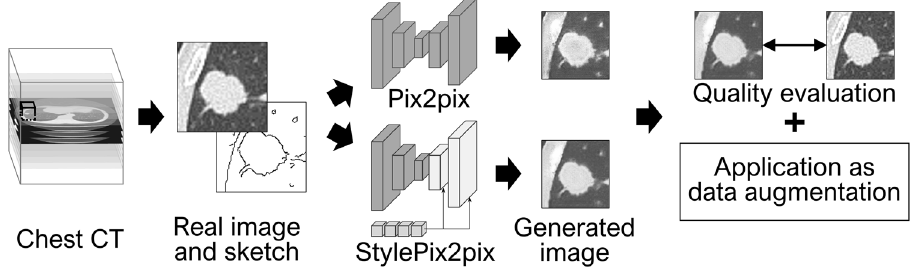
Figure 1. Outline of this study.